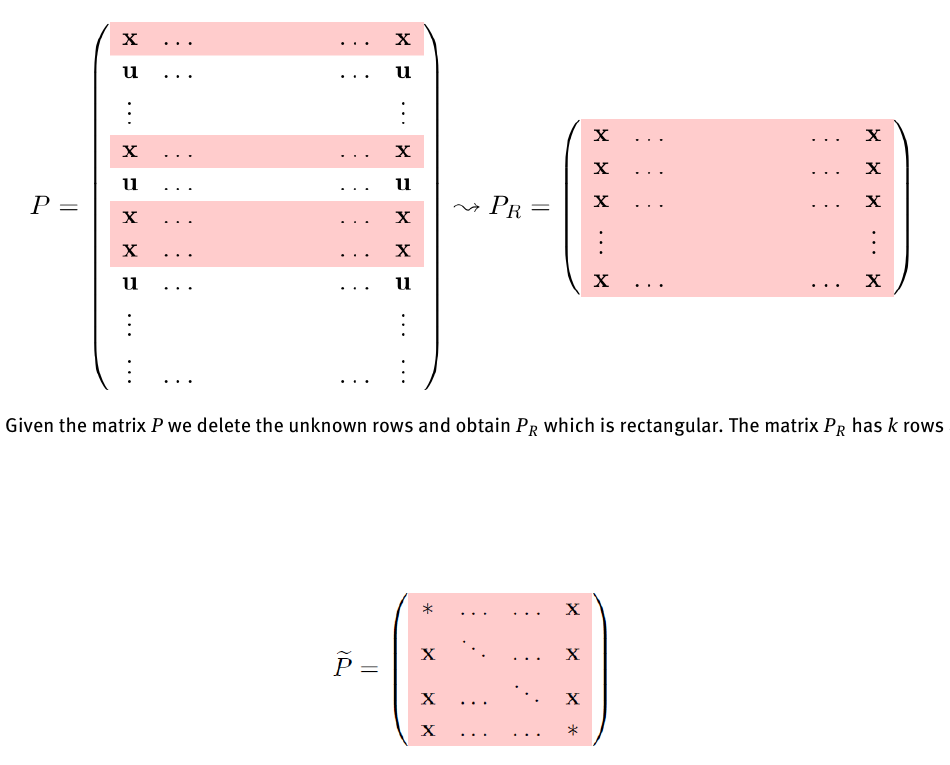
Figure 3: The matrix (cid:101) P is constructed by skipping the corresponding columns (cid:96) ∈ [ n − k ] and summing the skipped values row-wise onto the diagonal , * - summed diagonal elements according to